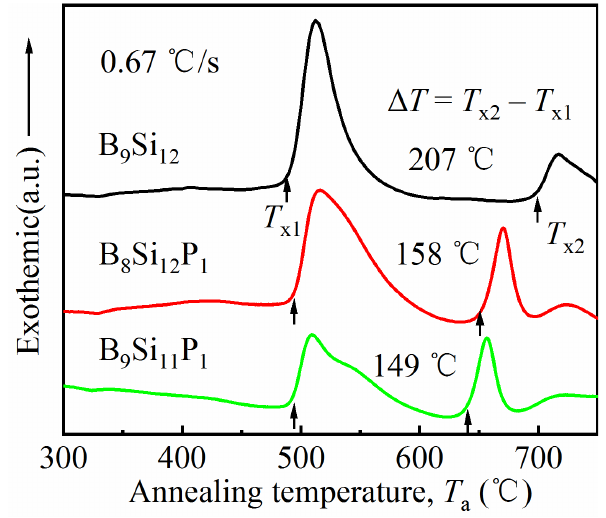
Figure 2. DSC curves of melt-spun B 9 Si 12 , B 8 Si 12 P 1 and B 9 Si 11 P 1 ribbons at a heating rate of 0.67 °C/s. T x1 and T x2 denote the first and second onset crystallization temperatures, respectively. Δ T = T x2 − T x1 , reflecting the annealing temperature range for obtaining single fine nanocrystalline grains.